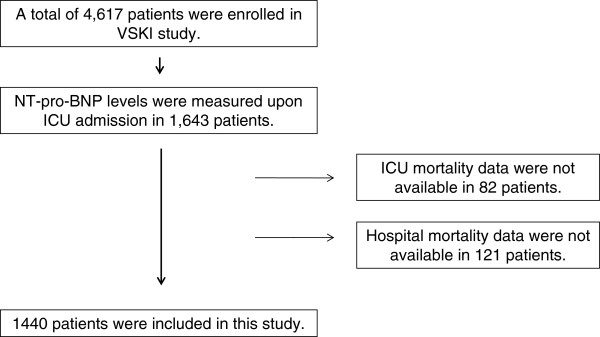
Enrolled patients.